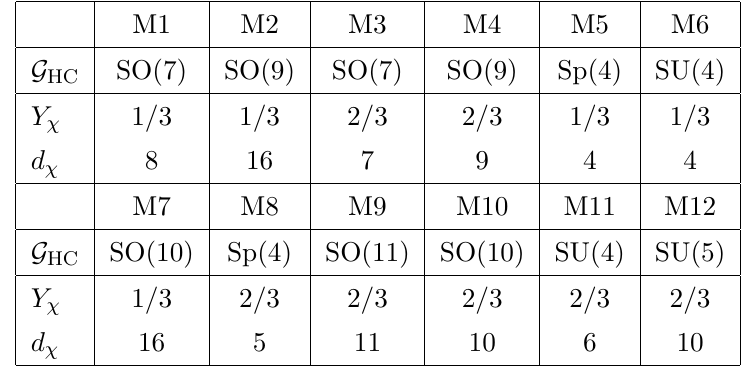
Table 2 . Values of d (cid:31) for the 12 models based on [4] (see [6, 35] for the model list assignments). couplings of a singlet pseudo-scalar were found to di(cid:11)er qualitatively and numerically. The main origin of this discrepancy traces back to the fact that couplings to the light scalar only arise via the mixing terms, thus diagonalising the mass matrix is not equivalent to diagonalising the couplings. Repeating the calculation in [36] for the case of composite color octet couplings from the mixing with light top partners, the ratio C